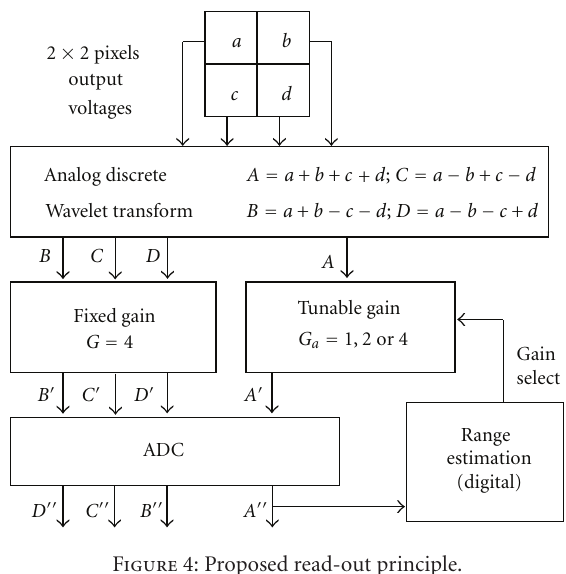
Figure 4: Proposed read-out principle.